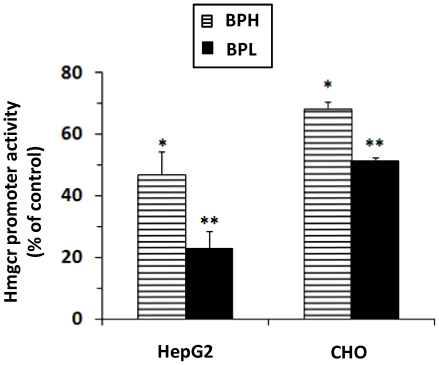
Effect of sterols on Hmgcr promoter expression.HepG2 and CHO Cells cultured in lipoprotein-deficient medium were transfected with BPL/BPH Hmgcr promoter (−961 to +43 bp)/firefly luciferase construct. Transfected cells were treated with of 25-Hydroxycholeserol (0.5 µg/ml) and of cholesterol (12 µg/ml) and incubated for 24–30 hrs. Cells were lysed and assayed for luciferase activity as well as protein concentration (for normalization). The normalized Hmgcr promoter activity in response to sterols (as percentage of control/basal) were expressed as Mean ± S.E. Each experiment was performed in triplicate and repeated at least three times. Significant reduction in promoter activity was observed in both HepG2 and CHO cells, to a greater extent in the case of BPL than BPH. (**) and (*) indicate p<0.01 and p<0.05 respectively, with respect to the mock (without stimulation).